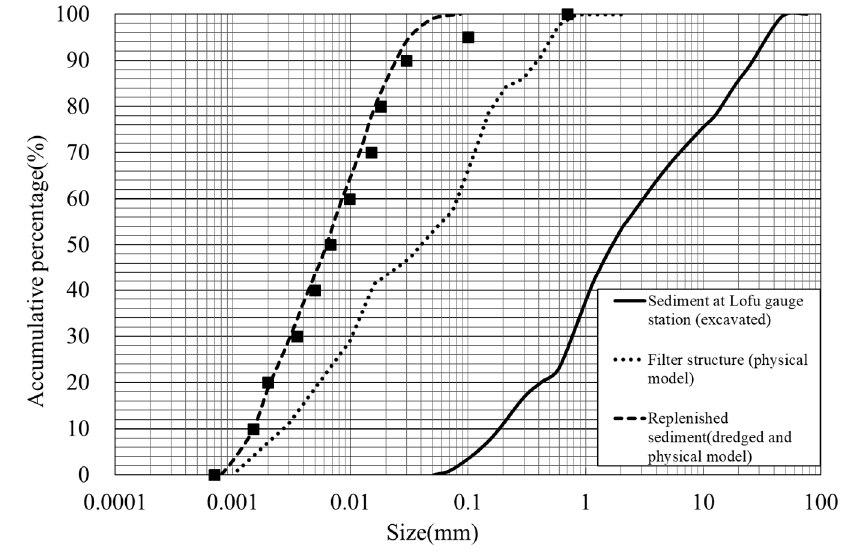
Figure 2. Sediment grain size distribution sampled in the field and used in the physical model.